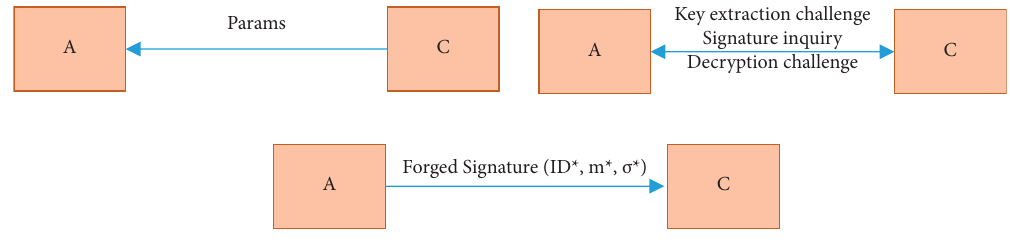
Figure 7: Schematic diagram of IBCES signature system under